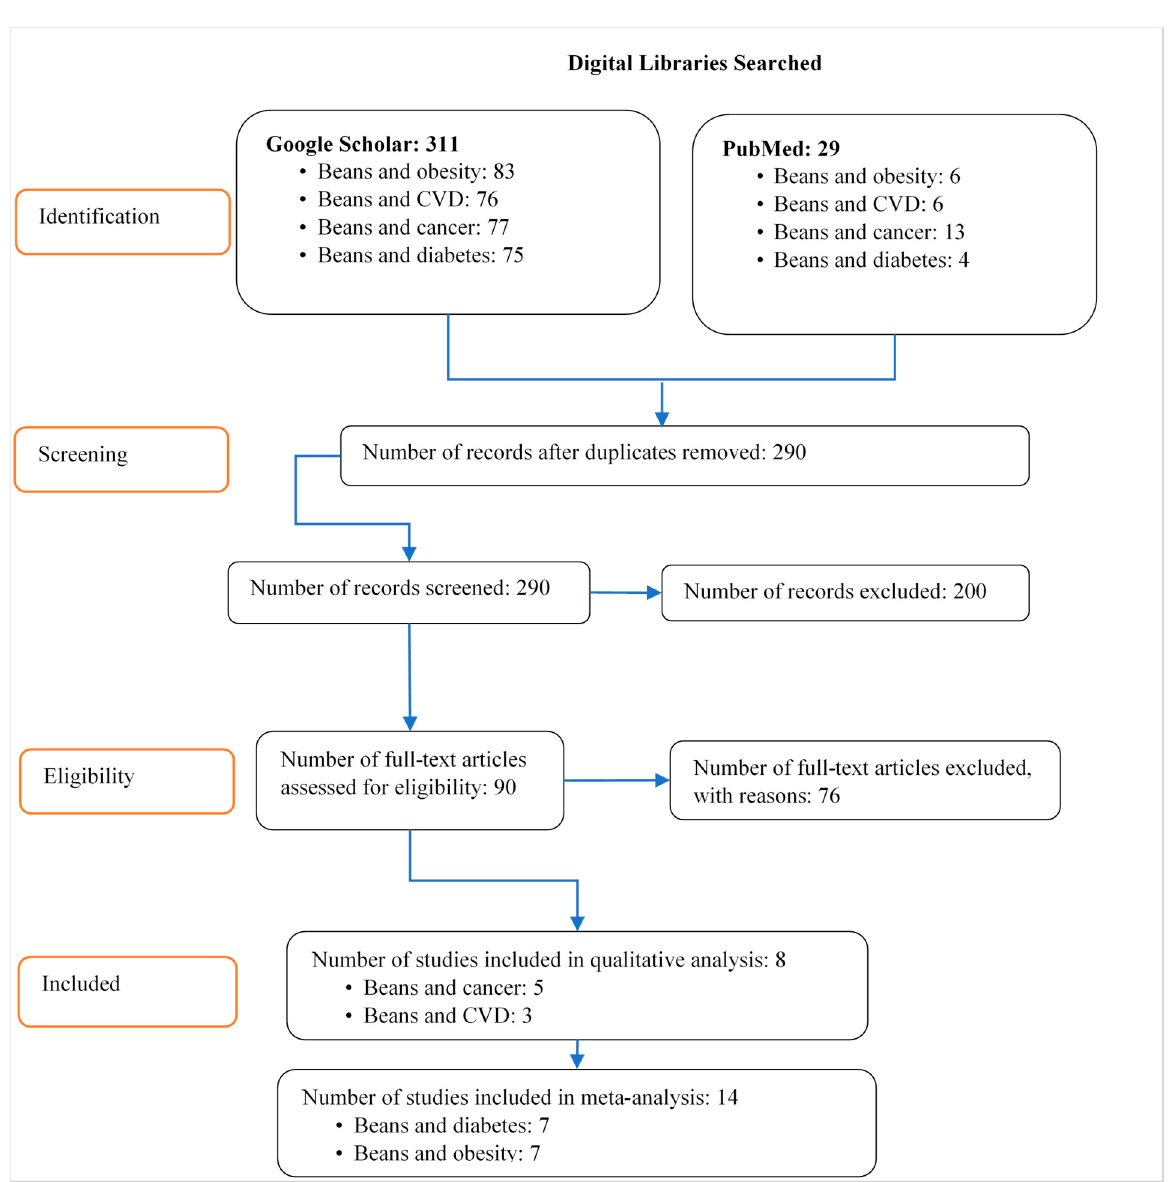
Figure 1. Flow chart indicating studies included in the systematic review and meta-analysis. Source: Author’s representation based on the PRISMA guidelines of Moher et al.